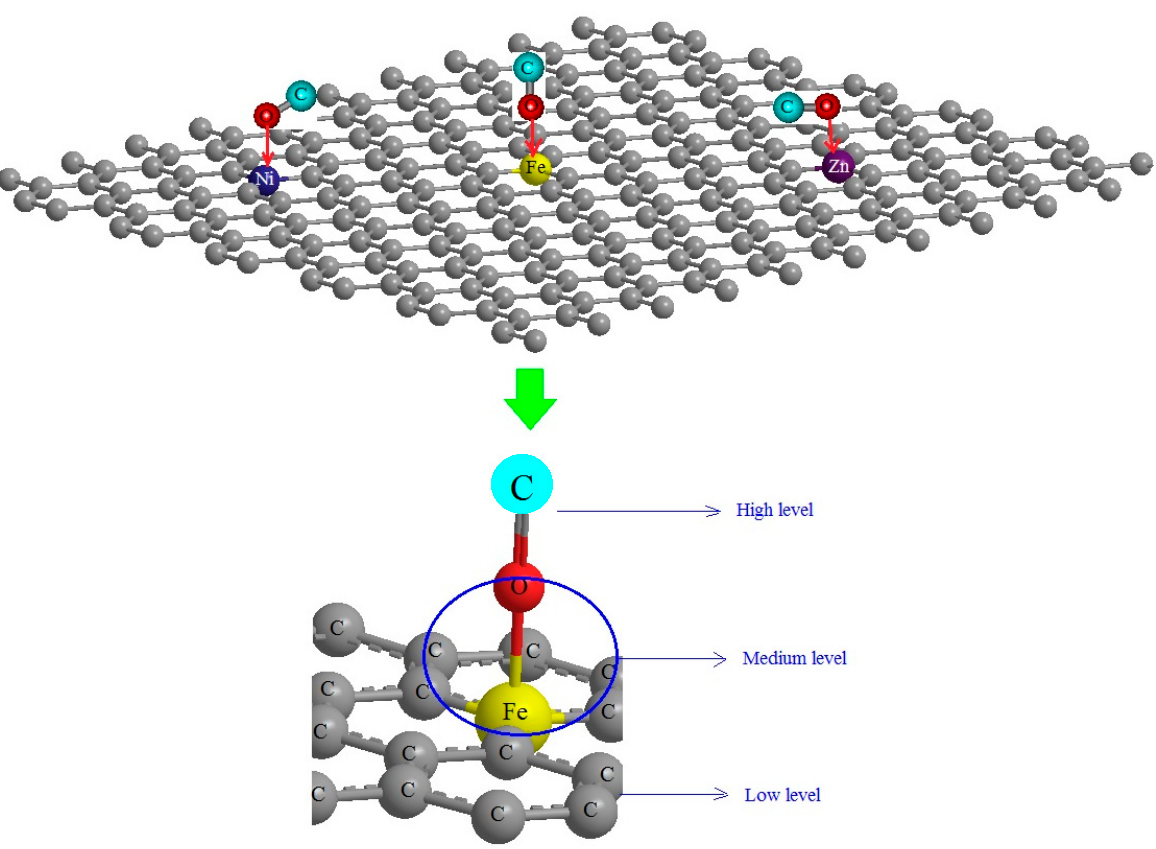
Scheme 2. The mechanism of the Langmuir adsorption of CO onto TM (Fe, Ni, Zn)-doped graphene nanosheets based on optimized coordination using the three-layered ONIOM method.